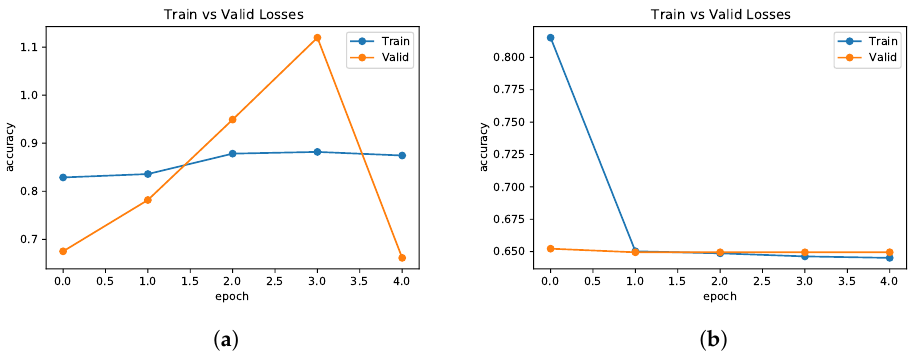
Figure 7. The loss (during training and validation) of both frozen and unfrozen AugFake-BERT models on the original dataset. ( a ) Loss of BERT (Frozen) Model; ( b ) Loss of BERT (Unfrozen)